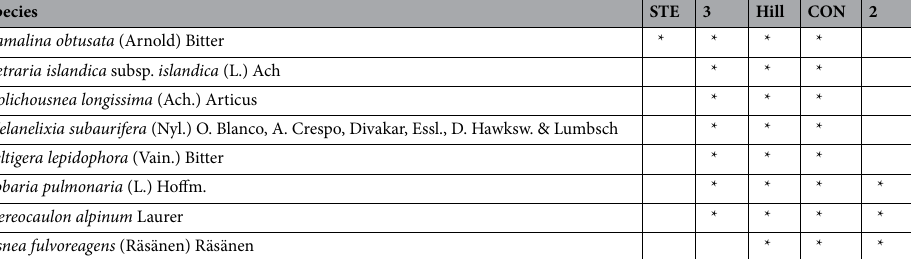
Peltigera lepidophora (Vain.) Bitter Lobaria pulmonaria (L.) Hoffm. Stereocaulon alpinum